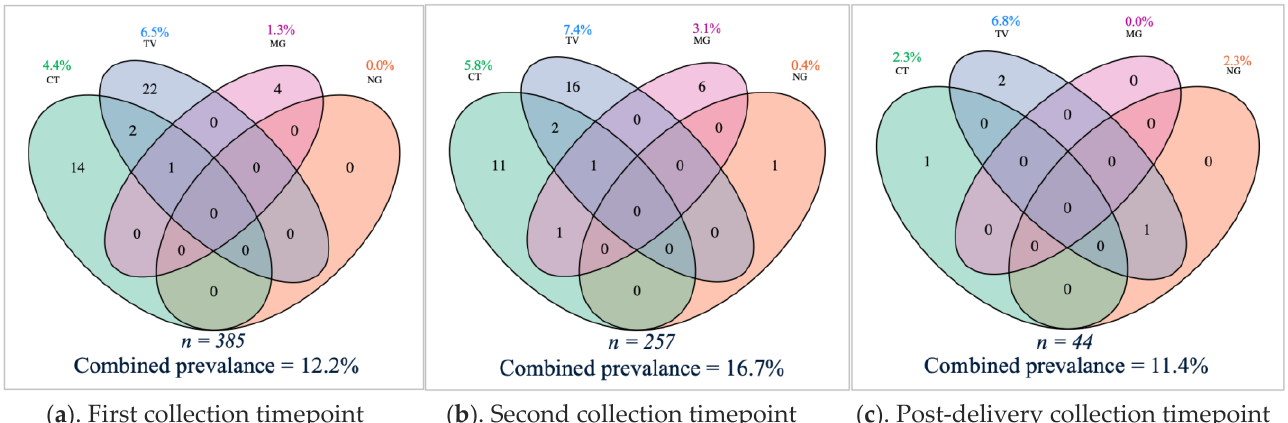
Figure 1. Venn diagrams with point prevalence and combined prevalence of Chlamydia trachomatis (CT), Neisseria gonorrhoeae (NG), Trichomonas vaginalis (TV) and Mycoplasma genitalium (MG) genital infections during and after pregnancy. The number represents the amount ( n ) of samples with a detected microorganism. Above is the individual point prevalence per genital infection and below each diagram is the total number of tested samples and the combined point prevalence of genital infections. ( a ) the sexually transmitted infection (STI) burden was 12.2% among the 385 vaginal samples tested at the first timepoint. ( b ) 16.7% among the 257 vaginal samples tested positive for at least one STI at the first timepoint. ( c ) The total STI burden post-delivery was 11.4% among 44 samples tested.